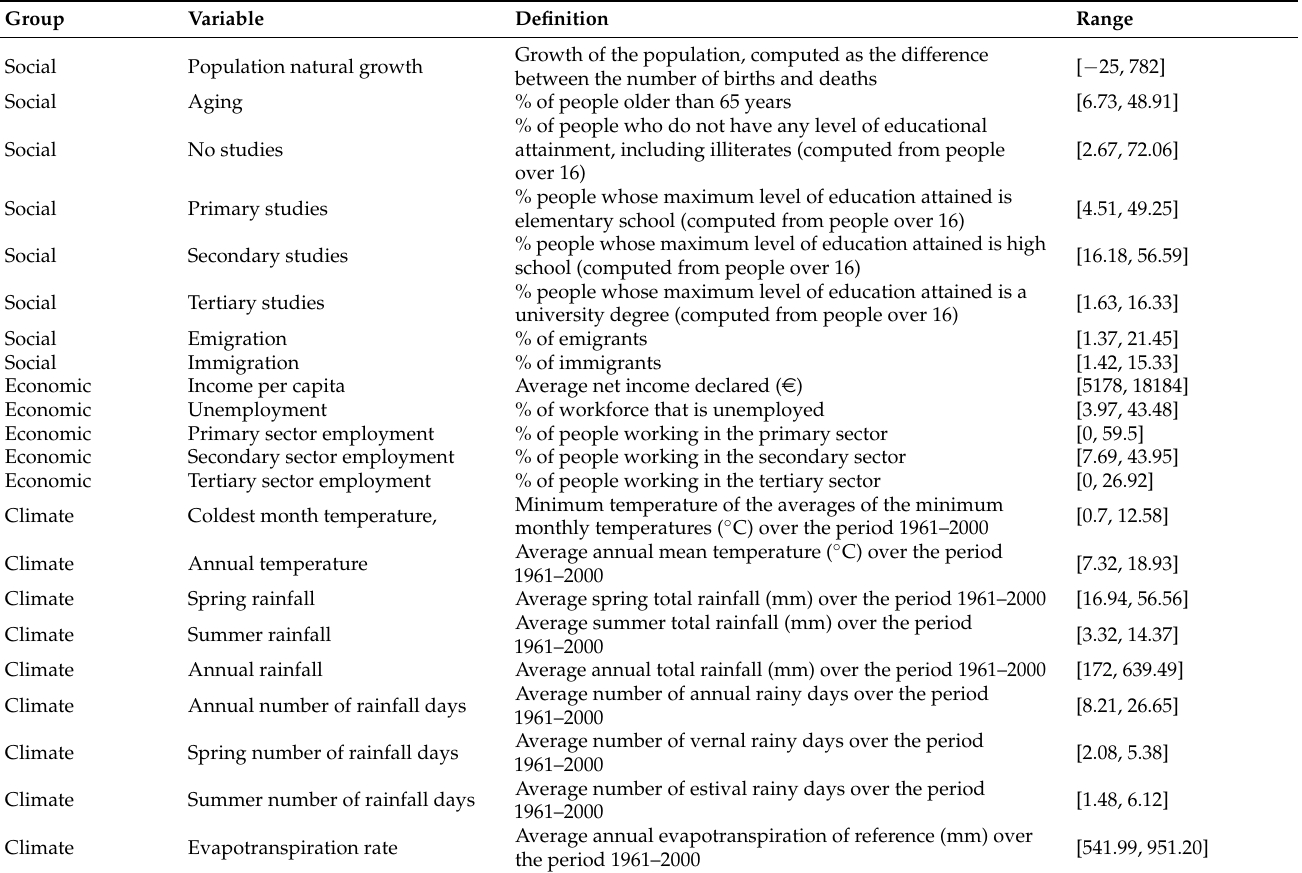
Table A2. Description of the socio-economic and climatic